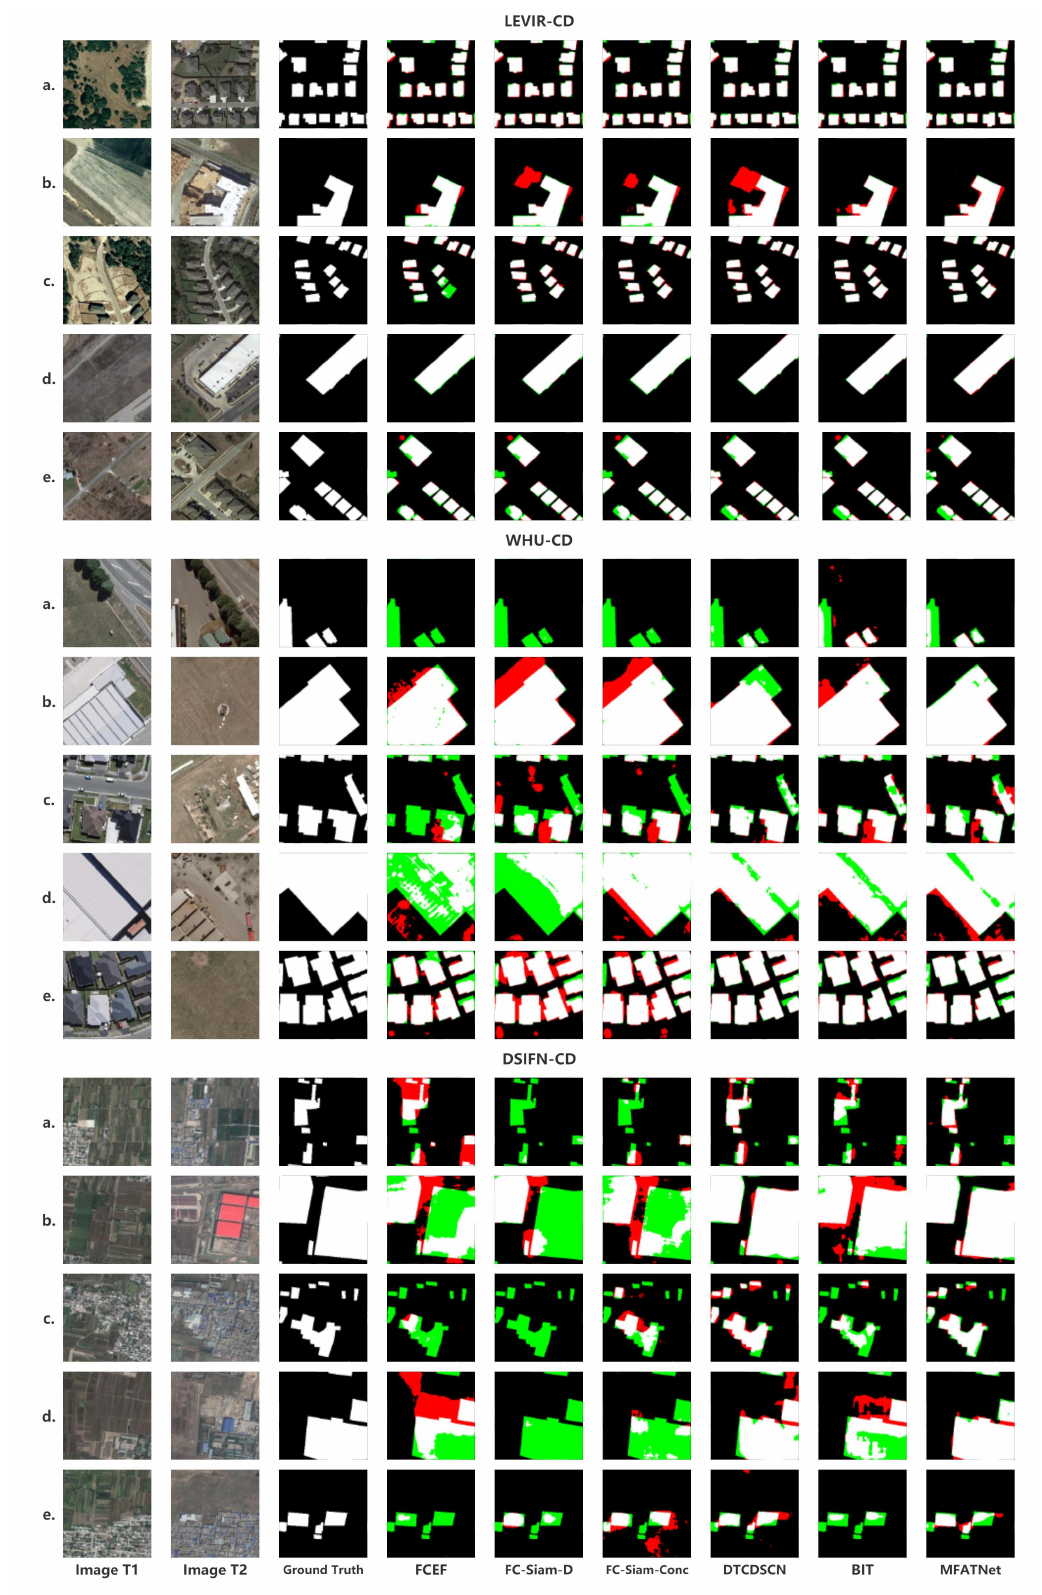
Figure 9. The visualization results of the different methods on the test sets of the three datasets ( a – e ); black represents TN , white represents TP , red represents FP , and green represents FN